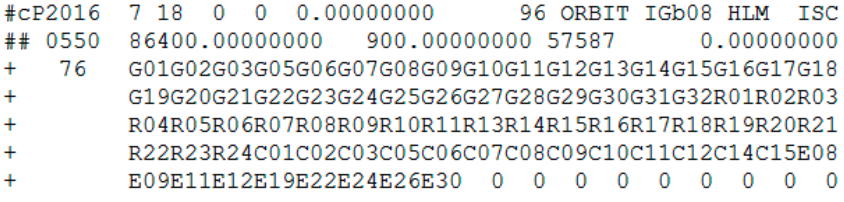
Figure 6. The header of the precise orbits information published by iGMAS on 18 July 2016.